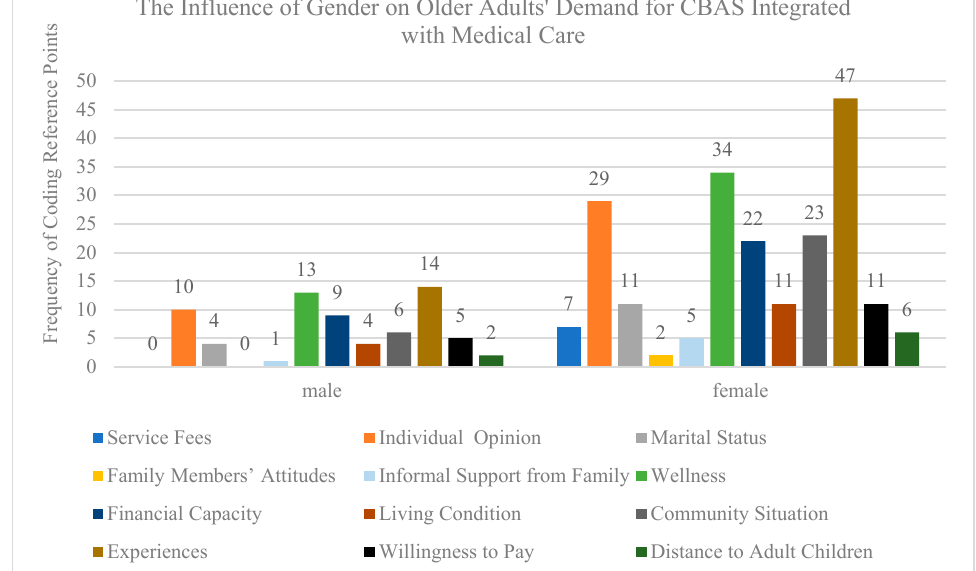
Figure A1. Difference in the factors influencing demand for CBAS integrated with medical care by gender.